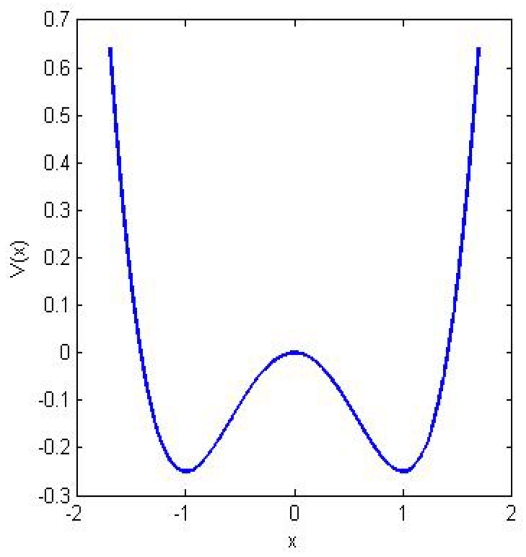
The mechanism of stochastic resonance. The double well potential V(x) represents a physical system with two stable states. In absence of noise a particle, which at one time is within one of the two wells, relaxes towards the intrawell minimum and then stops. When stochastic perturbation is added to this system the particle can hop between the two wells with a rate predicted by reaction-rate theory. If a weak periodic forcing is present the overall potential minimum changes periodically from one side to the other. Stochastic resonance happens when the typical escape time from the lower barrier and the periodic forcing are synchronized.